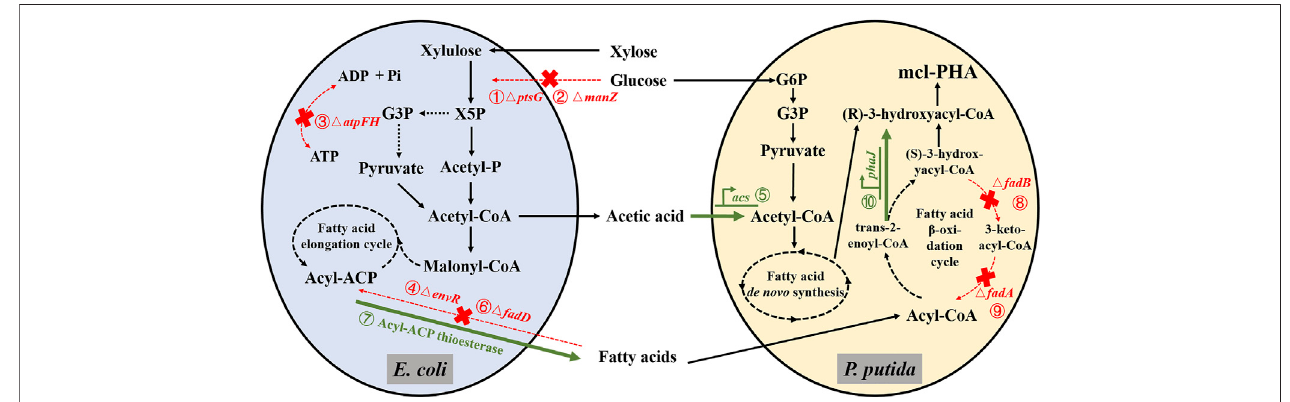
FIGURE1| Schematicdiagramofmetabolicengineeringfortheproductionofmcl-PHAfromamixtureofxyloseandglucosebythemicrobialconsortiumbasedon the concept of “ nutrientsupply-detoxi fi cation ” (Acronyms: X5P, Xylulose 5-phosphate; G3P, Glyceraldehyde-3-phosphate;Acetyl-P,Acetyl Phosphate; G6P, Glucose- 6-Phosphate. The red crosses in the biosynthetic pathway indicate the deletion of corresponding genes. The bold green arrows indicate the overexpression of corresponding genes. The related genetic engineering represented by ① , ② , ③ , and ④ was completed by (Liu et al., 2020), and the corresponding genetic engineering represented by ⑤ wascompletedby (Yang et al., 2019).The related genetic engineering represented by ⑥ , ⑦ , ⑧ , ⑨ ,and ⑩ wasconductedin thiswork).